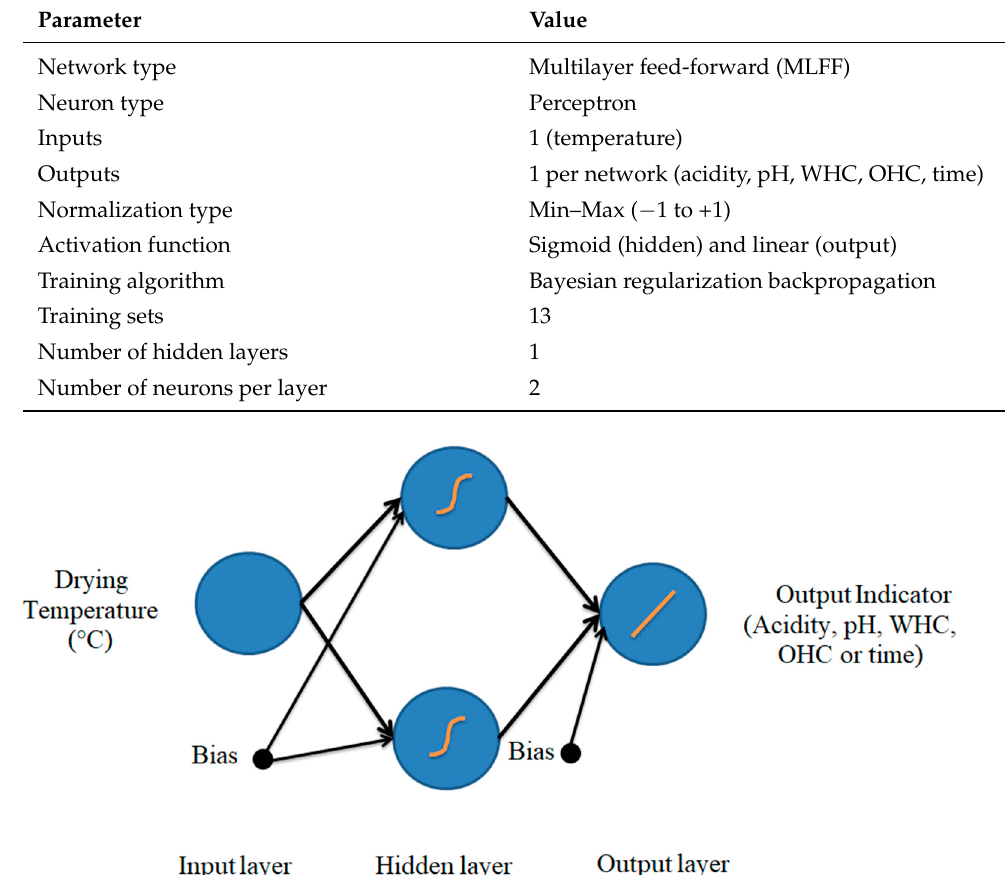
Figure 3. Artificial neural network data-based model .